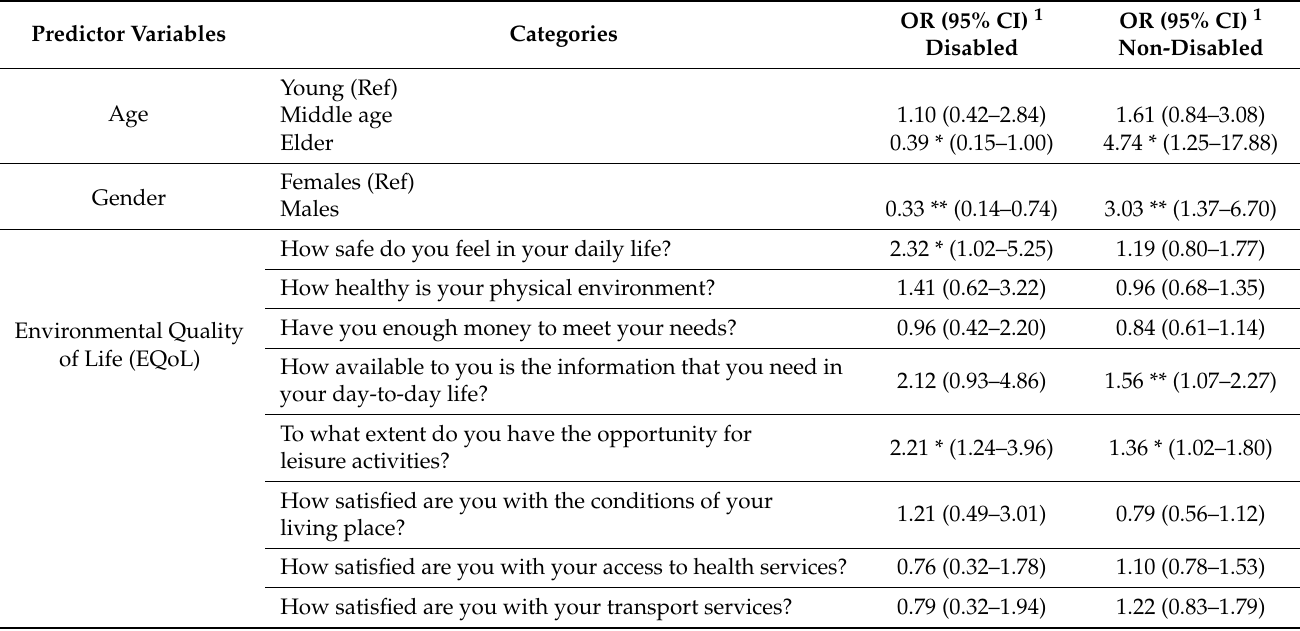
Table 3. Predictive role of EQoL in physical activity status of individuals with disabilities and without disabilities (Binary logistic regression, Multivariate